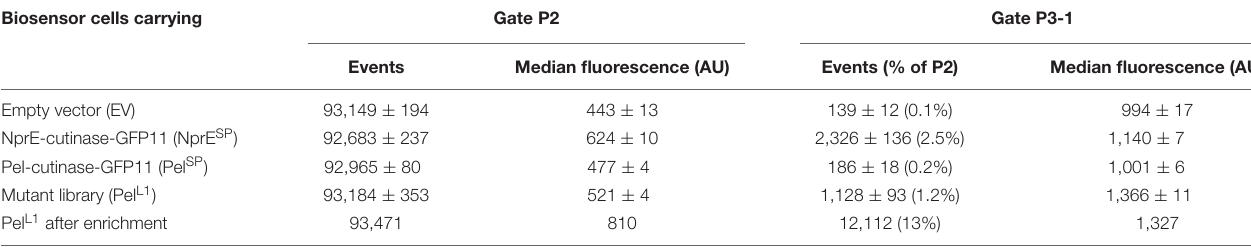
TABLE 1 | Fluorescence-activated cell sorting analysis of C. glutamicum K9 biosensor cells carrying the Pel L1 mutant library or control plasmids a , b . Biosensor cells